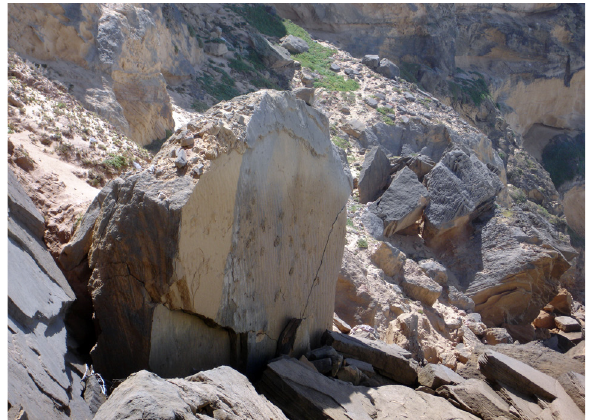
Figure 2: Roberts Rock in 2007.